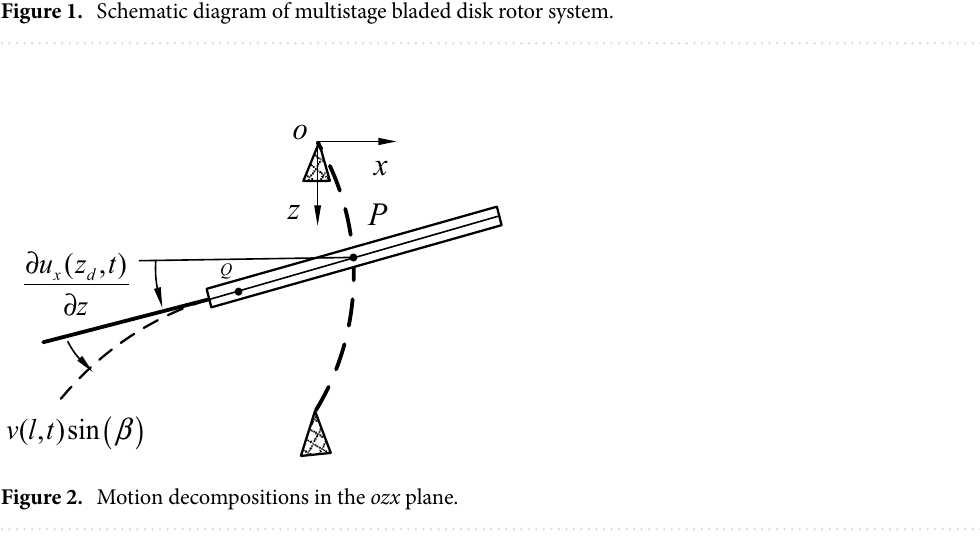
Figure 1. Schematic diagram of multistage bladed disk rotor system.